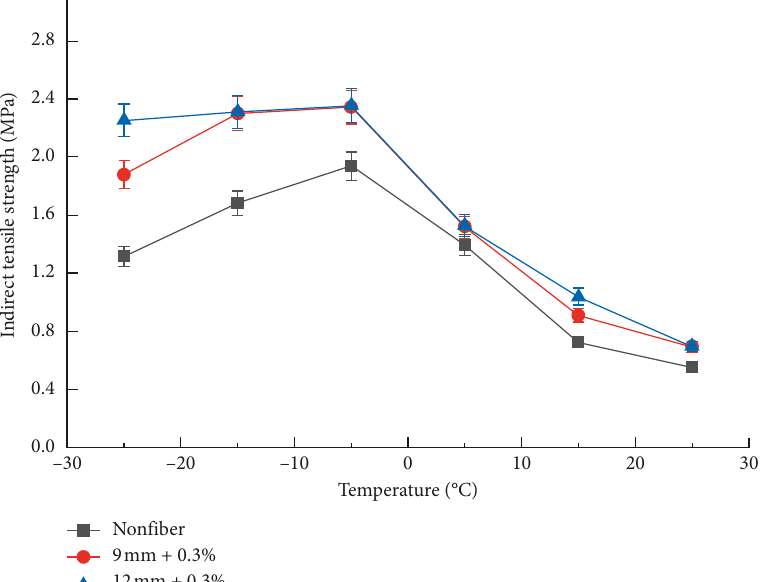
Figure 13: Results of indirect tensile strength.